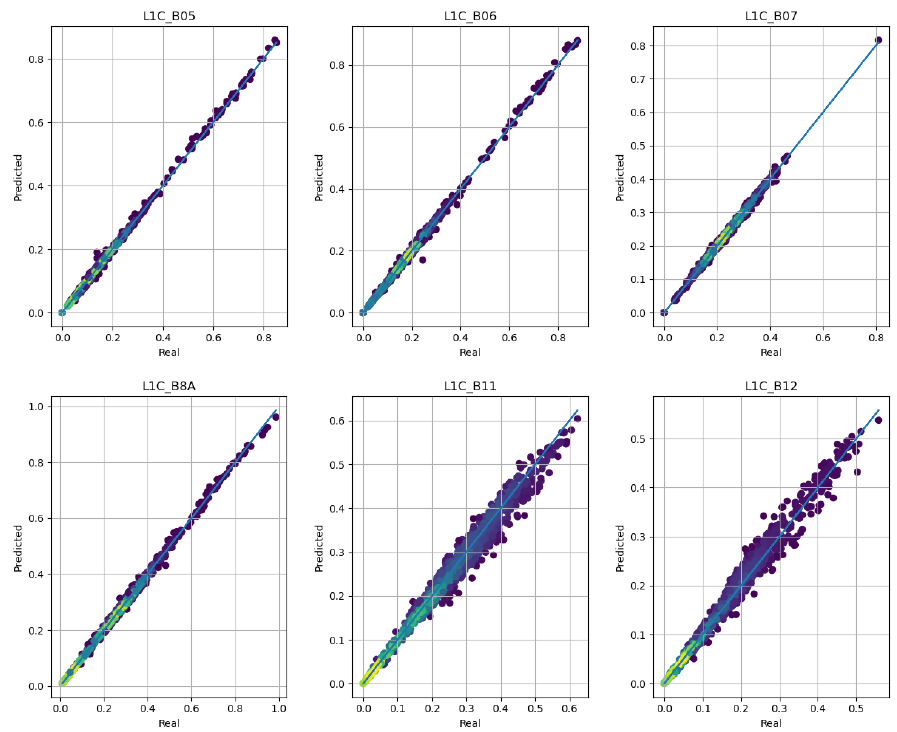
Figure 7. Scatterplots for the single-band regression (L1C). The colors indicate the density of points.